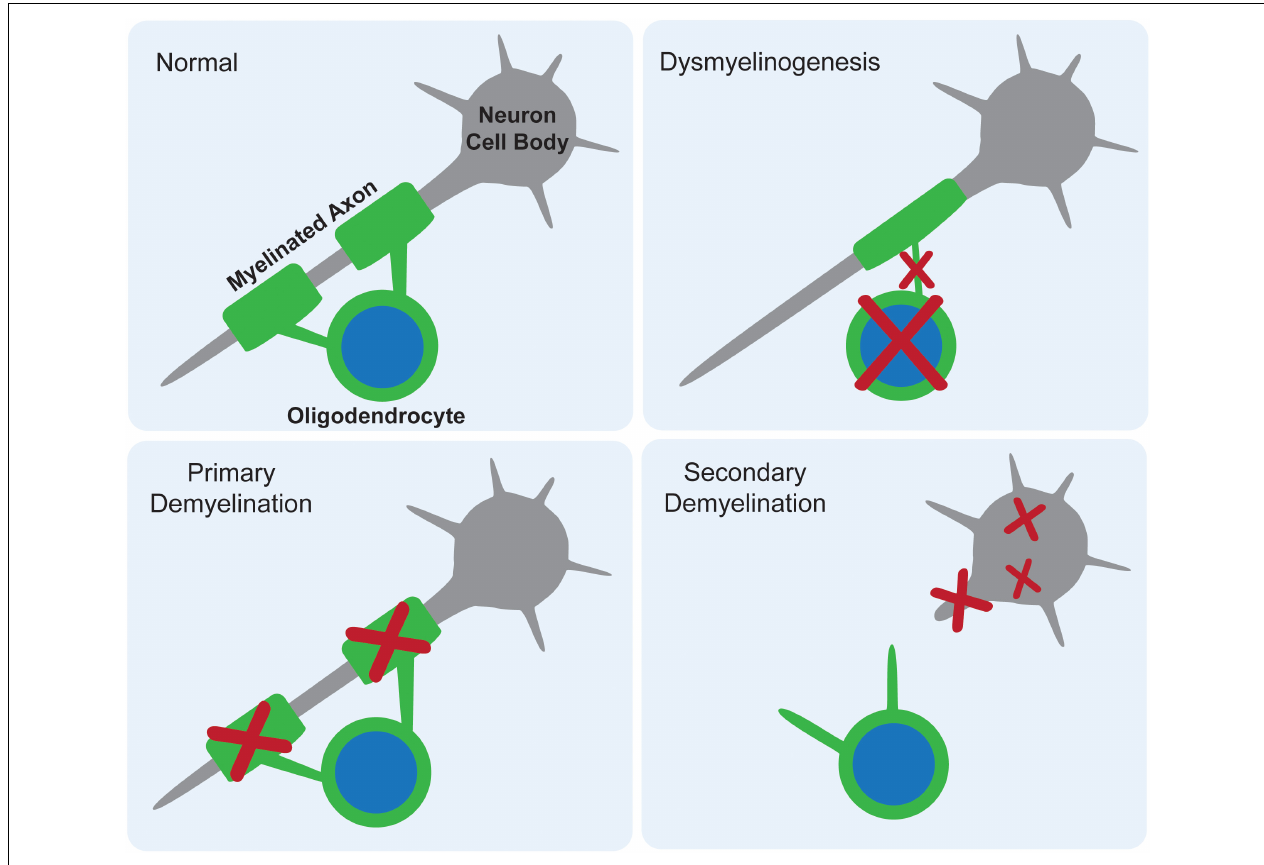
FIGURE 2 | Proposed mechanisms for myelin deficits in the central nervous system. In normal tissue, each oligodendrocyte modifies its own cell membrane to myelinate axons. If dysmyelinogenesis occurs, pathology within the oligodendrocyte, early myelin structures, or neuroaxonal communication leads to an abnormally myelinated axon. In primary demyelination, the oligodendrocyte is functional and myelin is formed properly, but then degraded. In secondary demyelination, neuroaxonal dysfunction leads to axonal loss, resulting in the overall loss of myelinated axons.